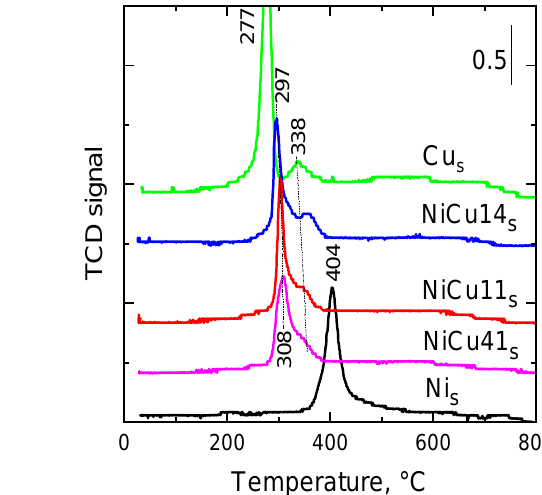
Table 4. T onset and H 2 consumption during TPR measurements together with surface area S BET and